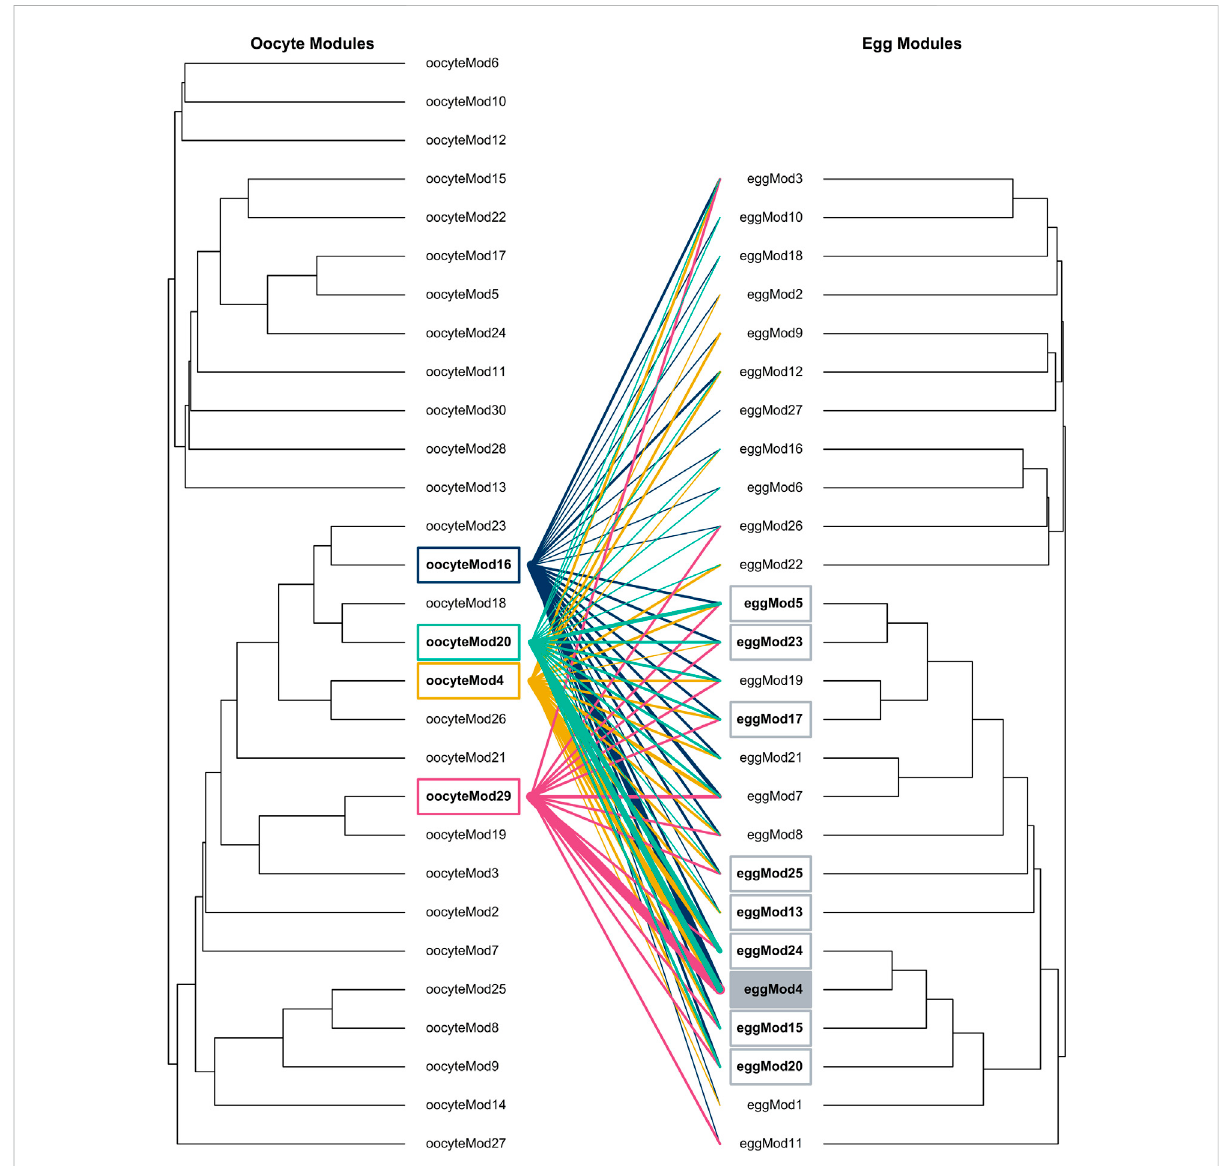
FIGURE 2 Dendrograms depicting gene module relationships for oocyte and egg tissues. Lines (moving left to right) indicate where genes from oocyte modules signi fi cantly correlated with time of season ( oocyteMod4 , oocyteMod16 , oocyteMod20 , oocyteMod29 ) are distributed throughout egg modules. The line color represents oocyte module membership, including gold, dark blue, turquoise, and magenta as oocyteMod4 , oocyteMod16 , oocyteMod20 , oocyteMod29 , respectively. Egg modules that shared signi fi cant overlap across these four oocyte modules are indicated with a gray box. The shaded box highlights ( eggMod4 ), the egg module that shared a signi fi cant number of genes with three of these oocyte modules ( oocyteMod16 , oocyteMod4 , and oocyteMod29 ). Line thickness scales to the percentage of genes from the oocyte modules that belong to each respective egg module. Line scale (from smallest to largest): < 1%, 1 – 10%, 10 – 20%, 20 – 30%, 30 – 40%, 40 – 50%, 50 – 60%, and 60 –